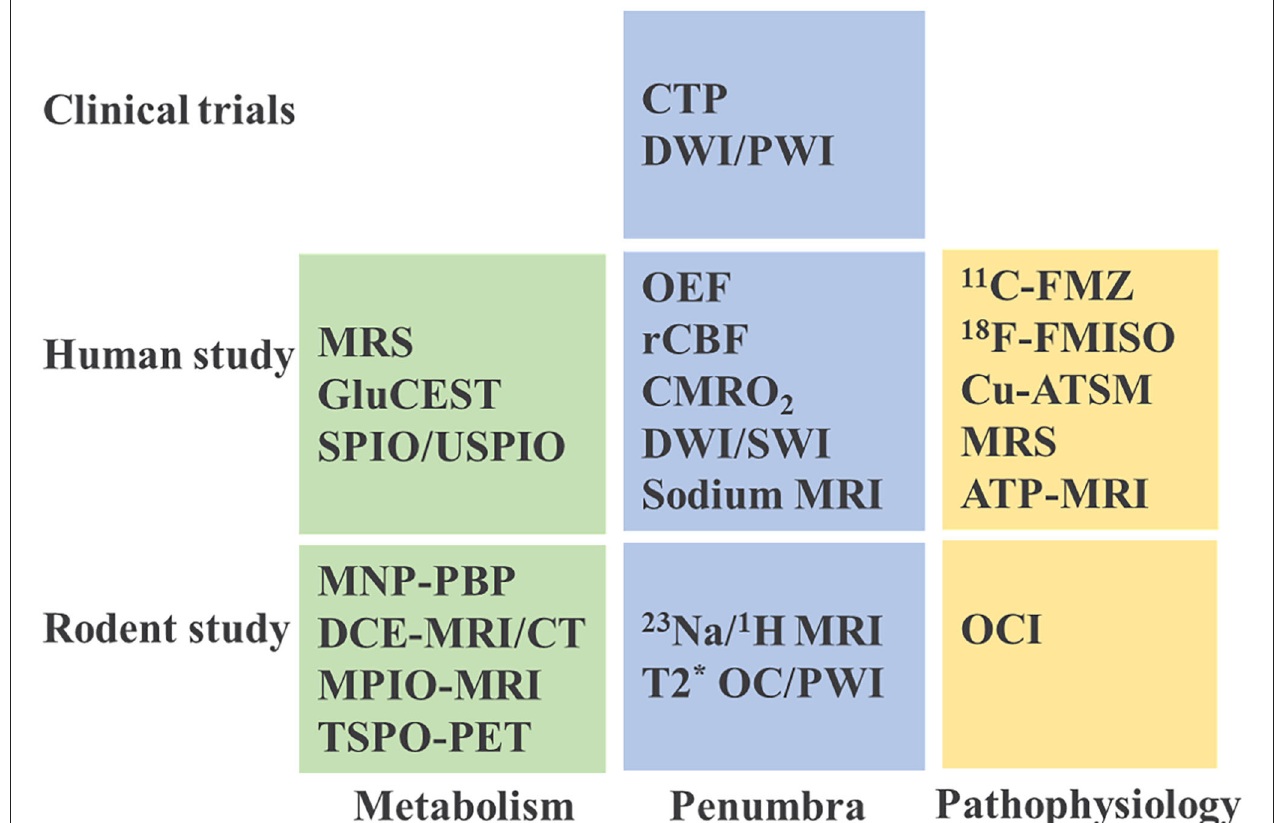
FIGURE 5 | Current imaging practice in stroke studies. MRS, magnetic resonance spectroscopy; GluCEST, glutamate weighted chemical exchange saturation transfer; SPIO, superparamagnetic iron oxide; USPIO, ultrasmall superparamagnetic iron oxide; MNP-PBP, magnetic nanoparticle-P-selectin binding peptide; MRI, magnetic resonance imaging; DCE, dynamic contrast enhanced; CT, computed tomography; MPIO, microparticles of iron oxide; TSPO-PET, translocator protein-positron emission tomography; OEF, oxygen extraction fraction; rCBF, regional cerebral blood flow; CMRO 2 , cerebral metabolic rate of oxygen; DWI/SWI, diffusion weighted imaging/ susceptibility weighted imaging; T * 2 OC/PWI, T * 2 oxygen challenge/perfusion-weighted imaging; 11 C-FMZ, 11 C-flumazenil; 18 F-FMISO, 18 F-Fluoromisonidazole; Cu-ATSM, copper-diacetyl-bis(N 4 -methylthiosemicarbazone); ATP, adenosine triphosphate; OCI, oxygen challenge imaging.